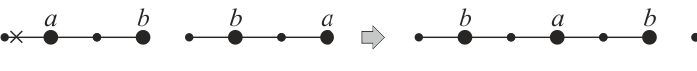
Figure 4. Interaction 1 a + 1 b = 1 b * , an SM operation.